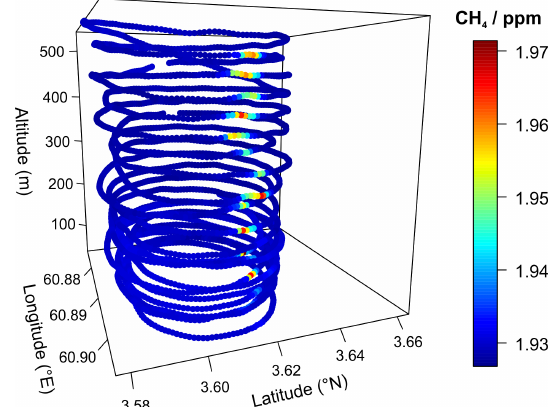
Figure B3. A 3-dimensional map of the flight pattern of the Sci- entific Aviation (Sci Av) aircraft sampling a CH 4 plume from an offshore O&G